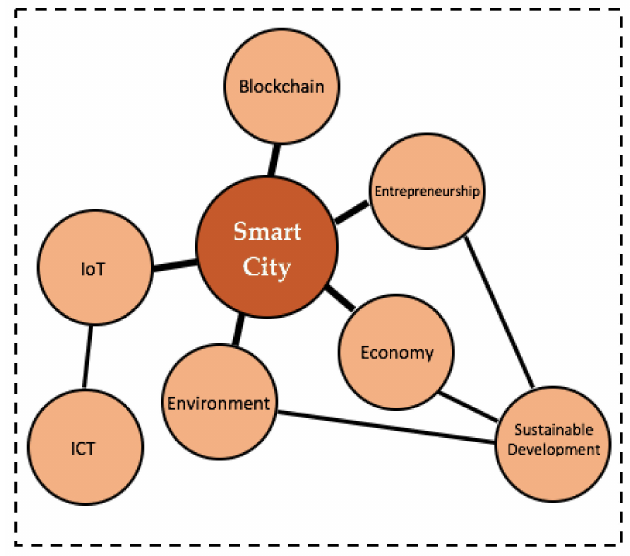
Figure 15. The correlations and their strengths between the keywords.